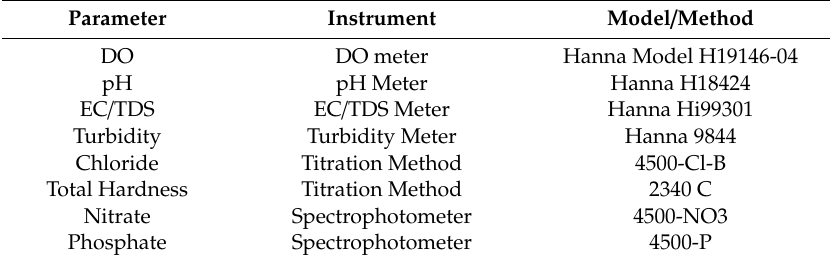
Table 1. Instruments used for onsite field measurement and laboratory analysis.